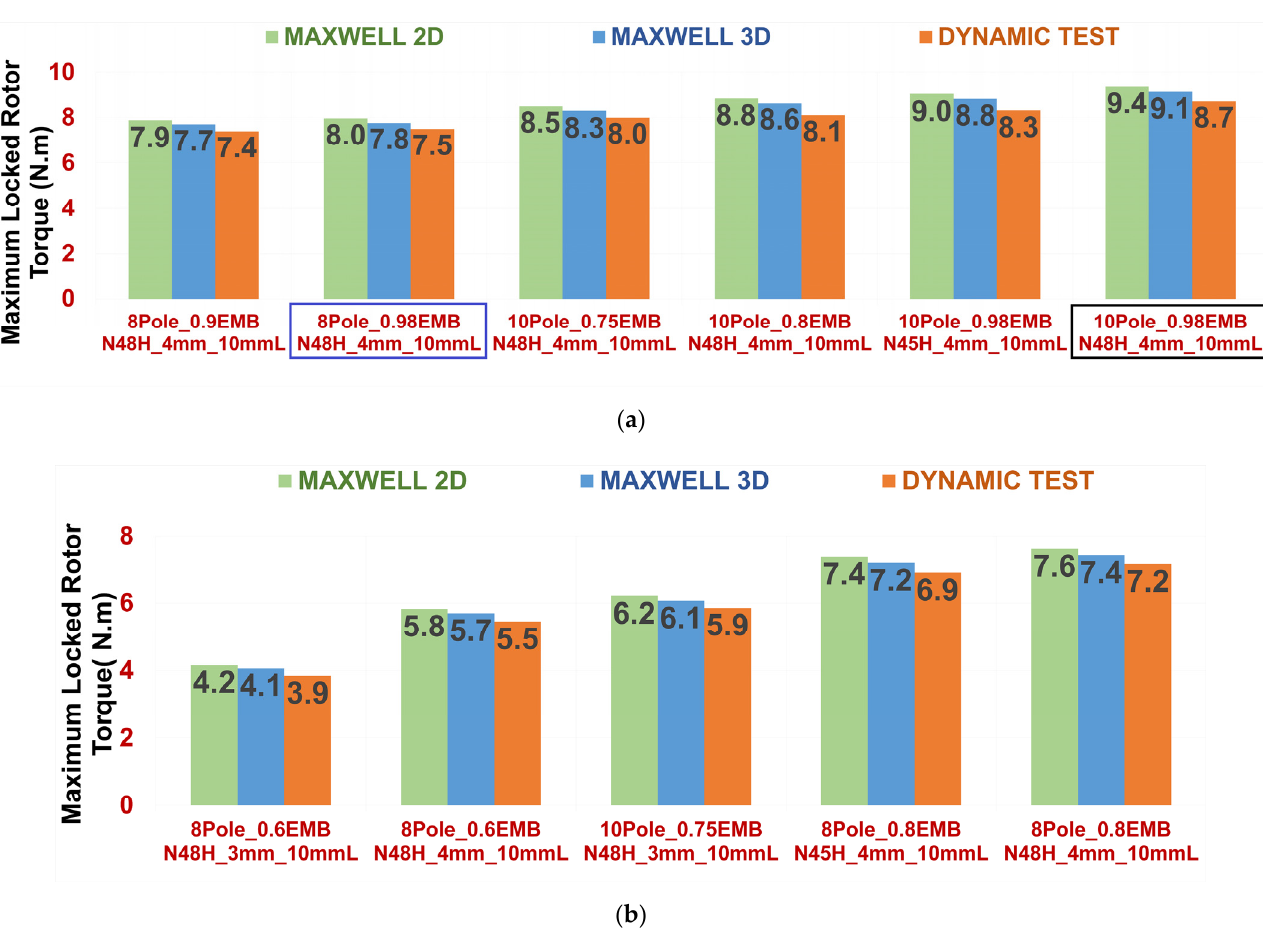
Figure 24. Locked-rotor test results of: ( a ) Higher torque density; ( b ) Lower torque density.